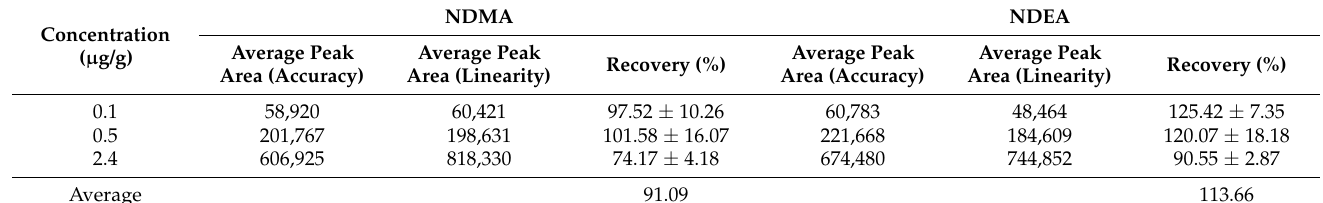
Table 4. Recoveries obtained in the accuracy